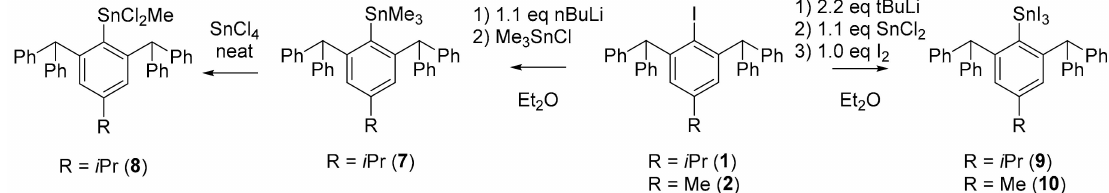
Figure 3. Preparation of arlytin compounds 7 and 8 as well as aryltin triioides 9 and 10